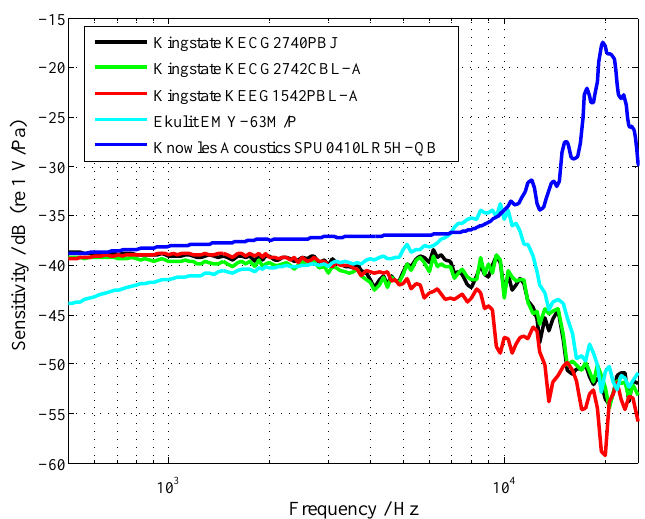
Figure 2. Frequency response of electret and MEMS microphones in the range from 500 Hz–25 kHz (adapted from Hoppe [19], with permission from c (cid:13) 2012 University of Freiburg).